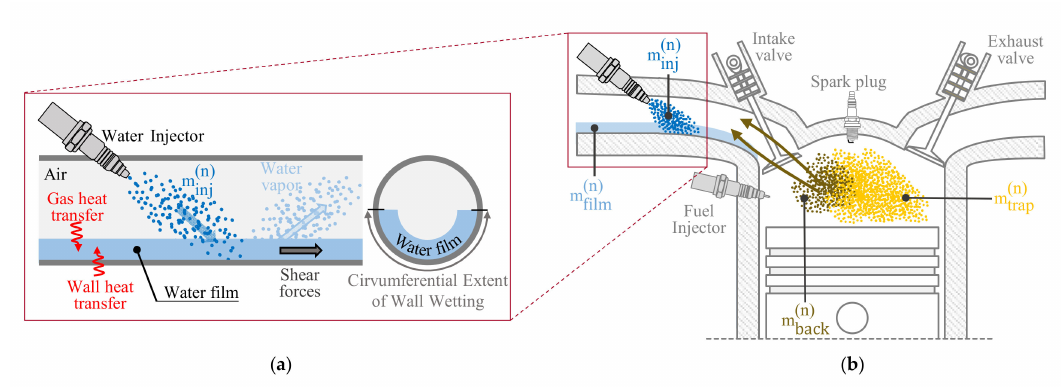
Figure 6. Schematic representation of ( a ) port-puddling model ( b ) injected water